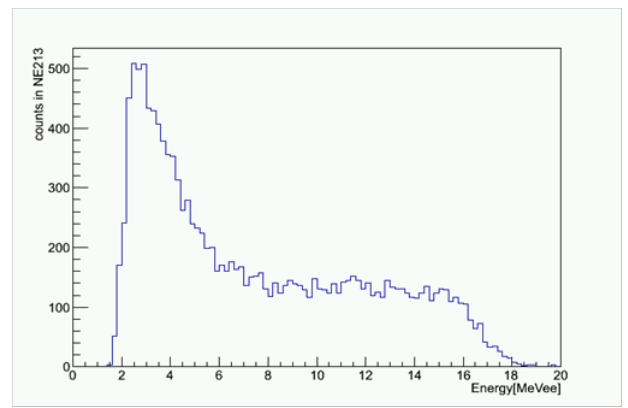
Figure 5. Scintillator response at given time / energy